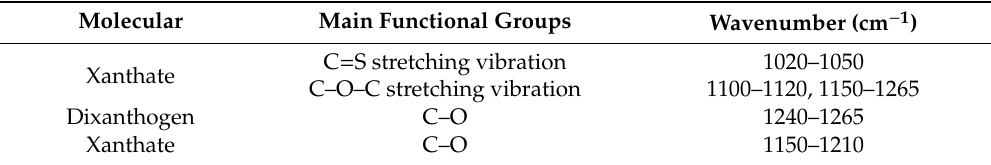
Table 5. Absorption peaks for the main functional groups of xanthate and dixanthogen.